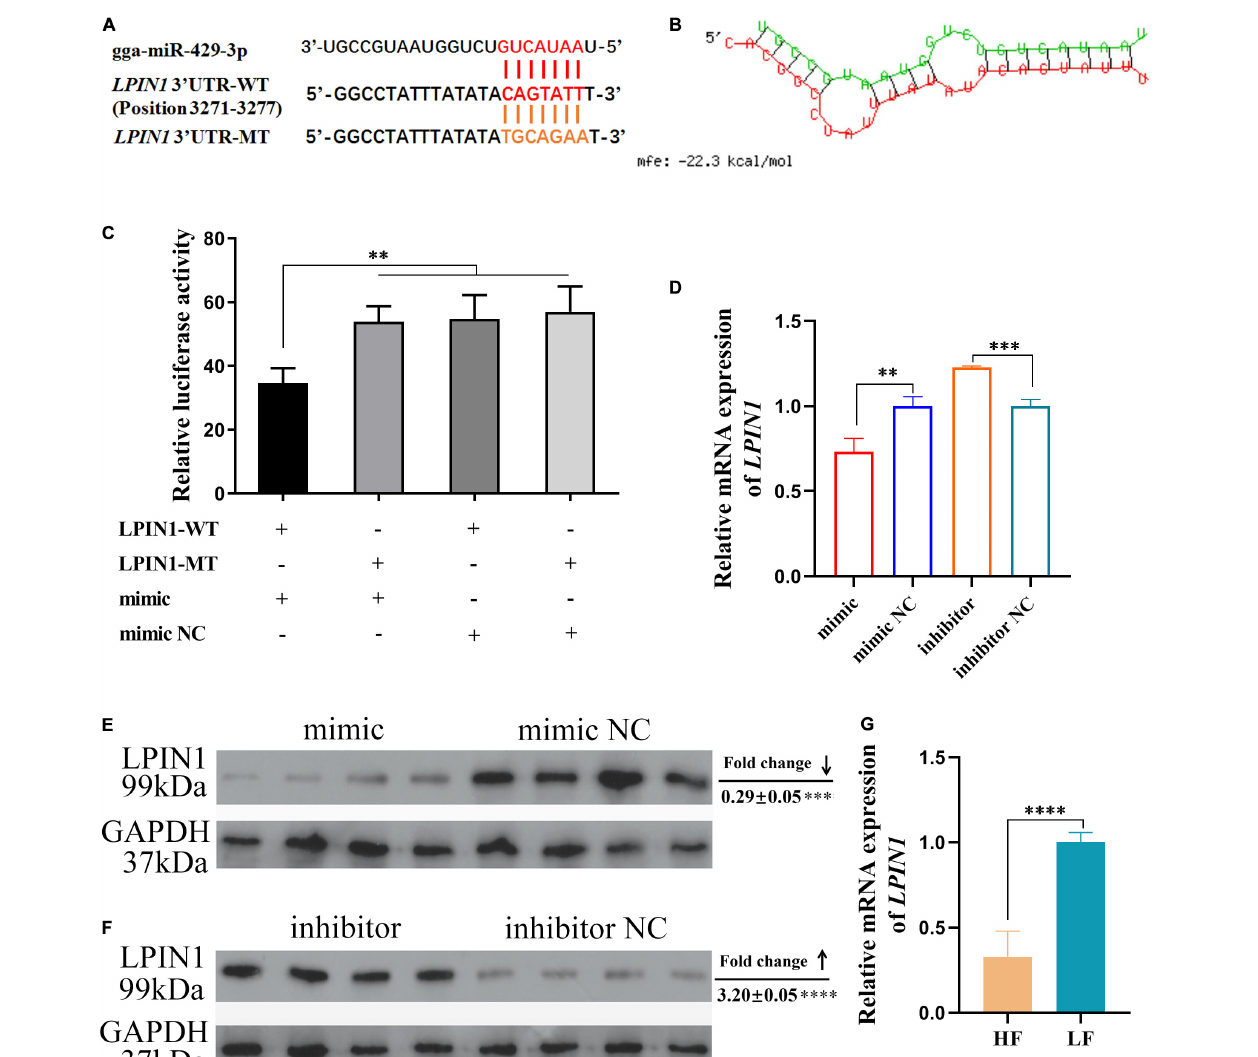
FIGURE 6 | LPIN1 is a target gene of miR-429-3p. (A) The target relationship prediction between miR-429-3p and LPIN1 3’UTR. (B) The stability prediction between miR-429-3p and LPIN1 3’UTR. (C) Dual-luciferase reporter assay for miR-429-3p and LPIN1 3’UTR. (D) Relative mRNA expression of LPIN1 in ICP-1 cells treated with miR-429-3p mimic or inhibitor. (E,F) Relative protein level LPIN1 in ICP-1 cells treated with miR-429-3p mimic or inhibitor. (G) Relative mRNA expression of LPIN1 in high-fat chicken and low-fat chicken. Data presented as mean ± SEM, * P < 0.05; ** P < 0.01; *** P < 0.001; **** P < 0.0001; ns: no significance.